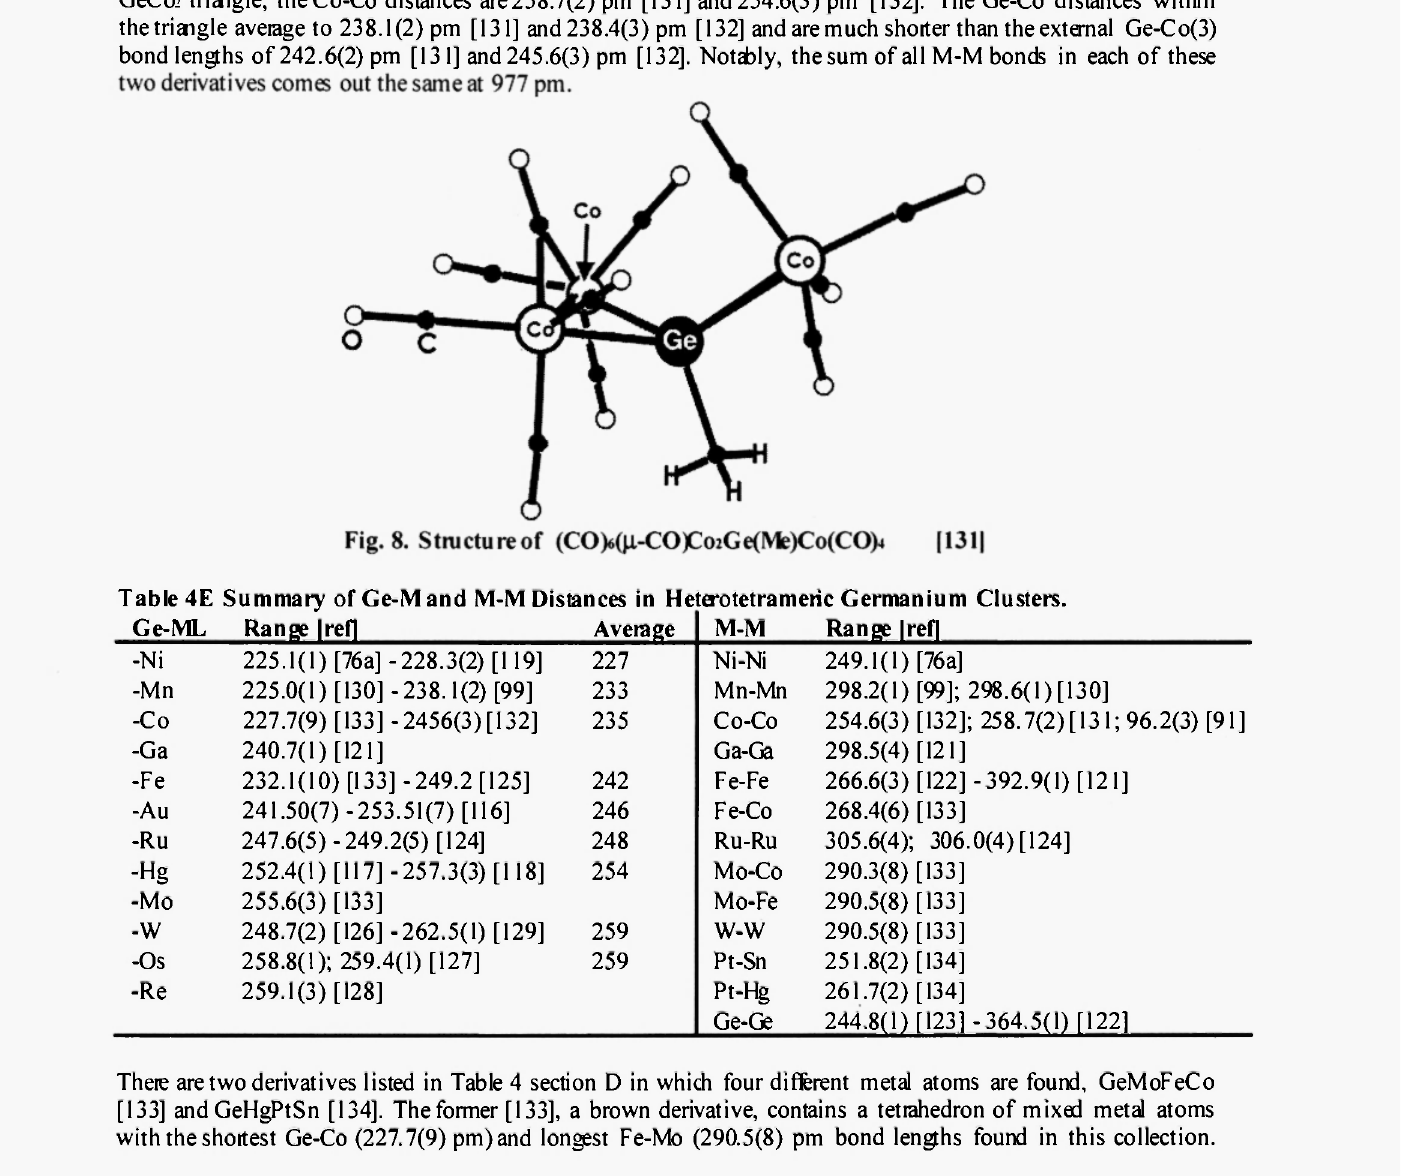
Table 4E Summary ofGe-IWand M-M Distances in Heterotetrameric Germanium